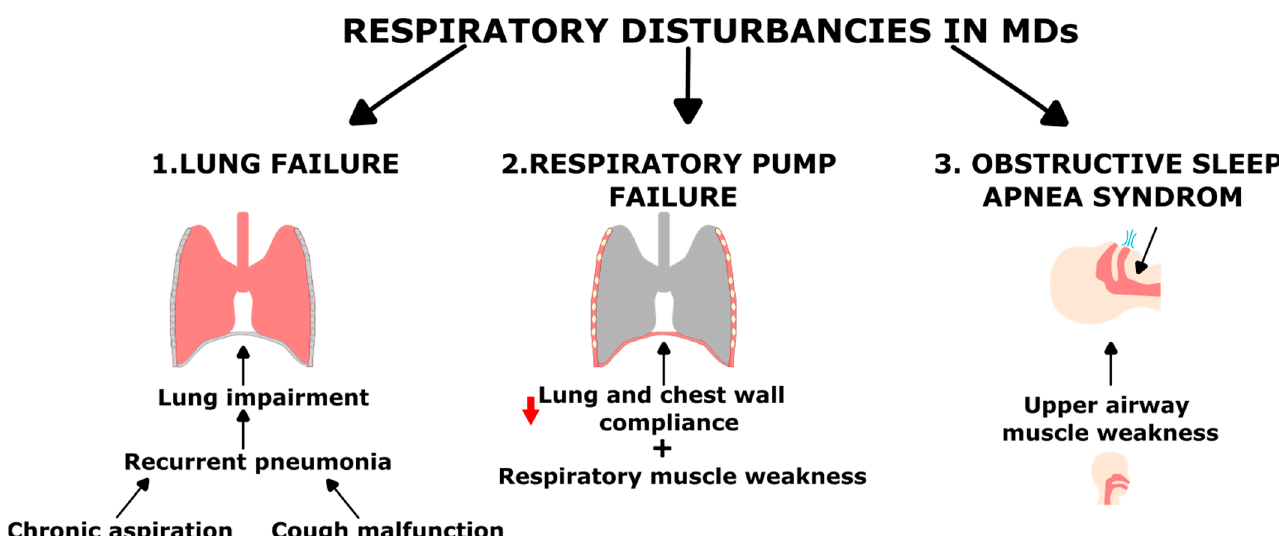
Figure 2. Diagram summarizing the three main causes of respiratory disturbances in MDs. (1) The main cause of lung failure is recurrent pneumonia usually secondary to cough inefficiency or chronic aspiration. (2) Respiratory pump failure is associated to respiratory muscle weakness (decreased pressure generating ability) combined to low respiratory system compliance (increased work of breathing). (3) Obstructive sleep apnea syndrome (OSAS) is also a common respiratory impairment, weakness of upper airway muscle enabling the inspiratory airway closure.